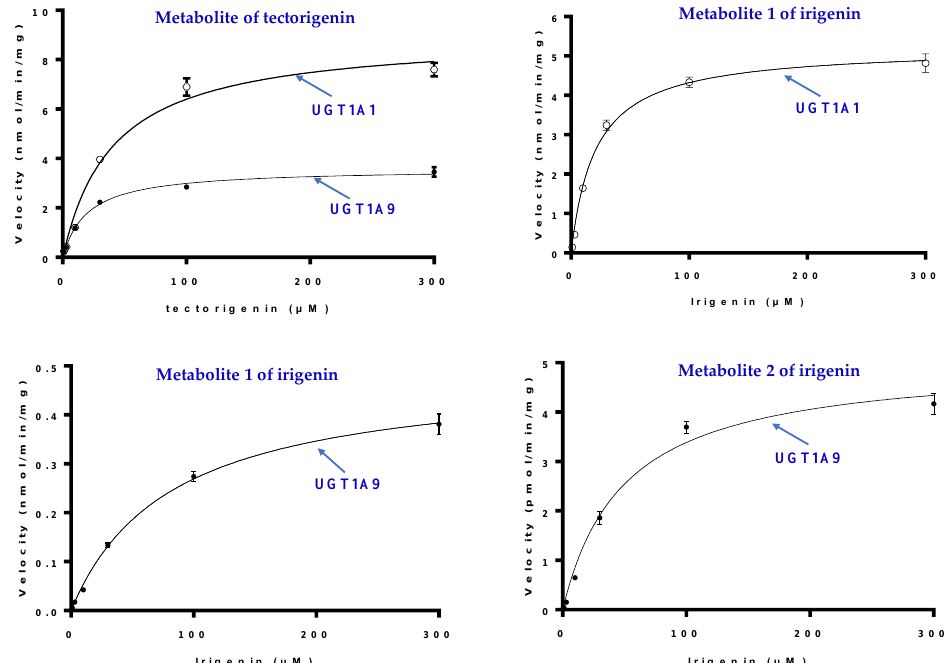
Figure 7. Kinetics of tectorigenin and irigenin metabolism by UGT1A1 and UGT1A9 (mean ± SE, n = 3) (the hollow circle for UGT1A1 and the filled circle for UGT1A9).